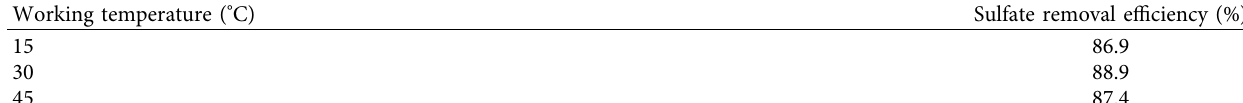
Figure 6: Solution pH value in seawater after addition of NaAlO 2 and CaO at series of dosages. Table 3: Sulfate removal efficiency in seawater at different working temperatures.